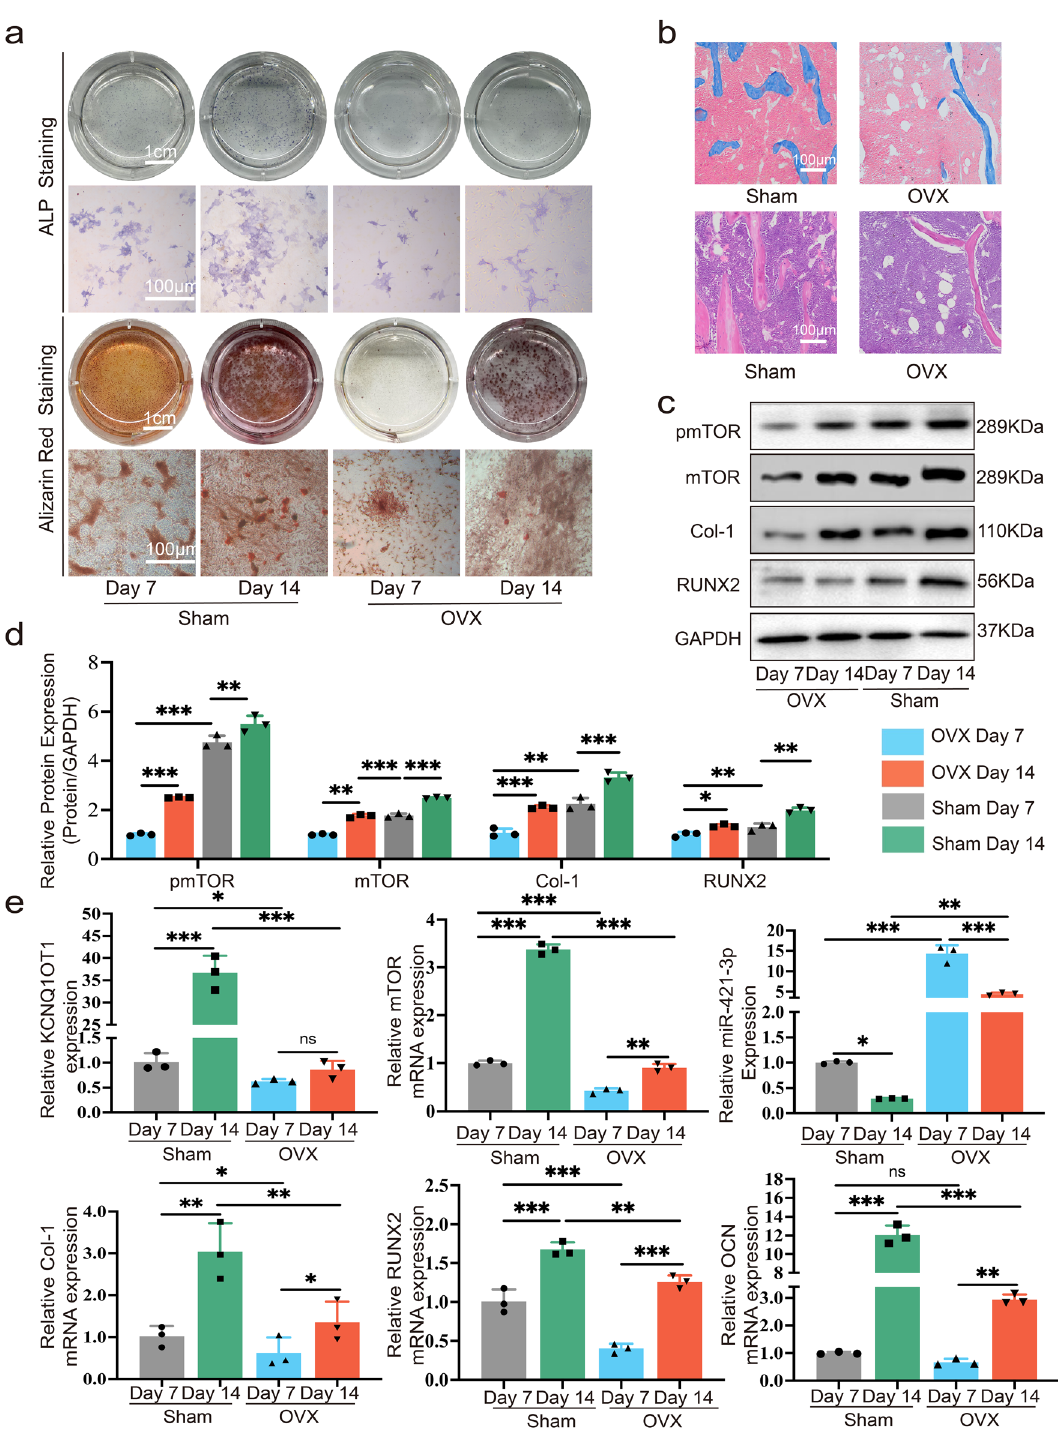
Figure 7. The expression levels of KCNQ1OT1, miR-421-3p, mTOR, and osteogenesis-related markers during osteogenic differentiation in vitro. ( a ) Osteoblasts in sham-operated and OVX groups were isolated and grown in a condition that induces osteogenic differentiation for 7 and 14 days, ALP staining and Alizarin Red staining were used to showed the degree of osteogenic differentiation. ( b ) Masson and HE staining of femurs from both sham and OVX group mice. ( c , d ) Protein expression levels of pmTOR, mTOR, Col-1 and RUNX2 of osteoblasts were detected by western blot after isolated and cultured in a condition that induces osteogenic differentiation for seven days and 14 days. Uncropped Western blot images are shown in Supplementary Fig. 9. ( e ) The RNA expression of KCNQ1OT1, miR-421-3p, mTOR, Col-1, RUNX2 and OCN of osteoblasts isolated from sham and OVX mice femurs and induction in vitro for seven and 14 days was detected by qRT-PCR. *P < 0.05, **P < 0.01, ***P <